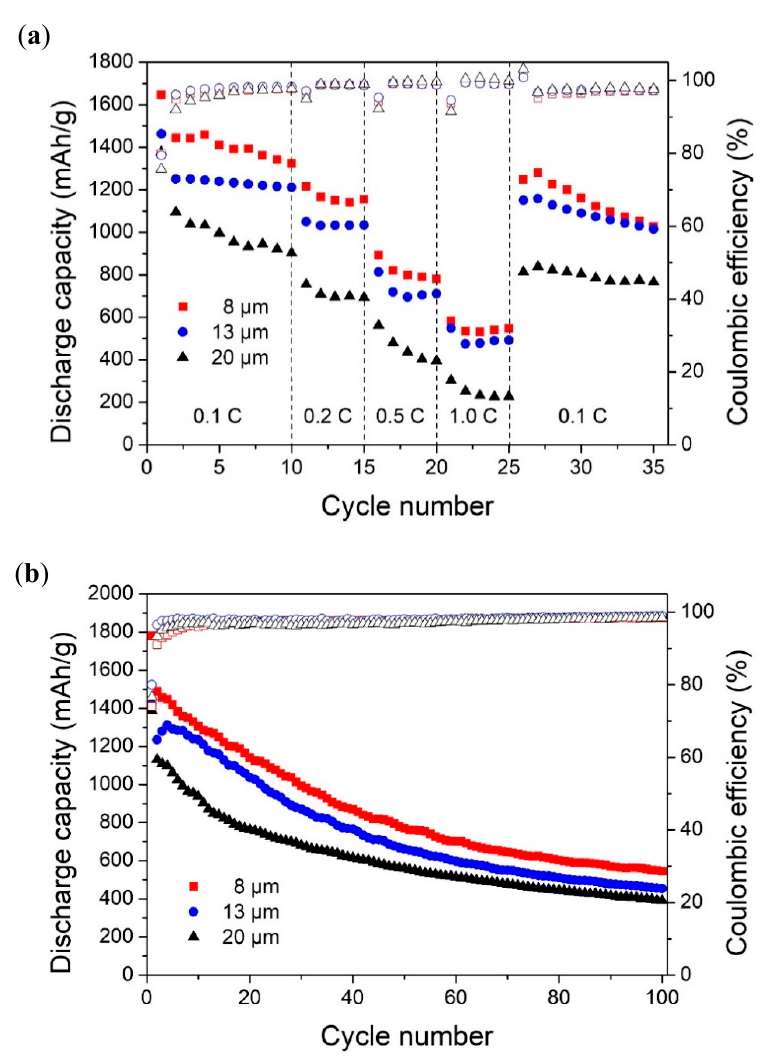
Figure 4. ( a ) Rate capabilities of Si micropillars measured at the varying current rates. ( b ) Discharge capacities of Si micropillars and corresponding coulombic efficiencies as a function of cycle number.